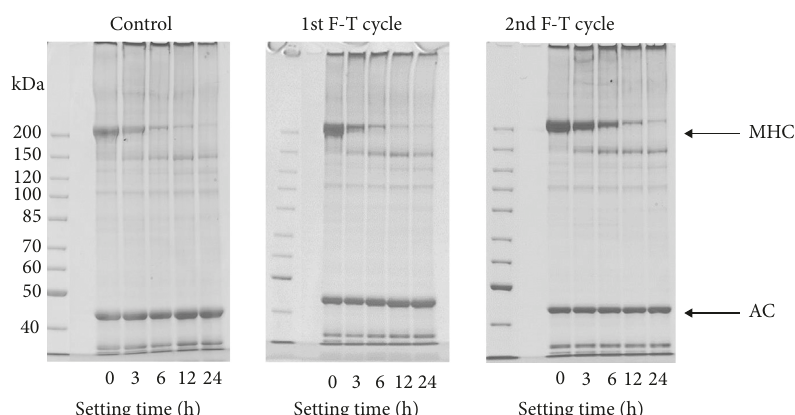
Figure 8: SDS-PAGE pattern of direct and/or two-step heated gel prepared from each frozen surimi. M, MHC, and AC indicate the protein marker, myosin heavy chain, and actin,